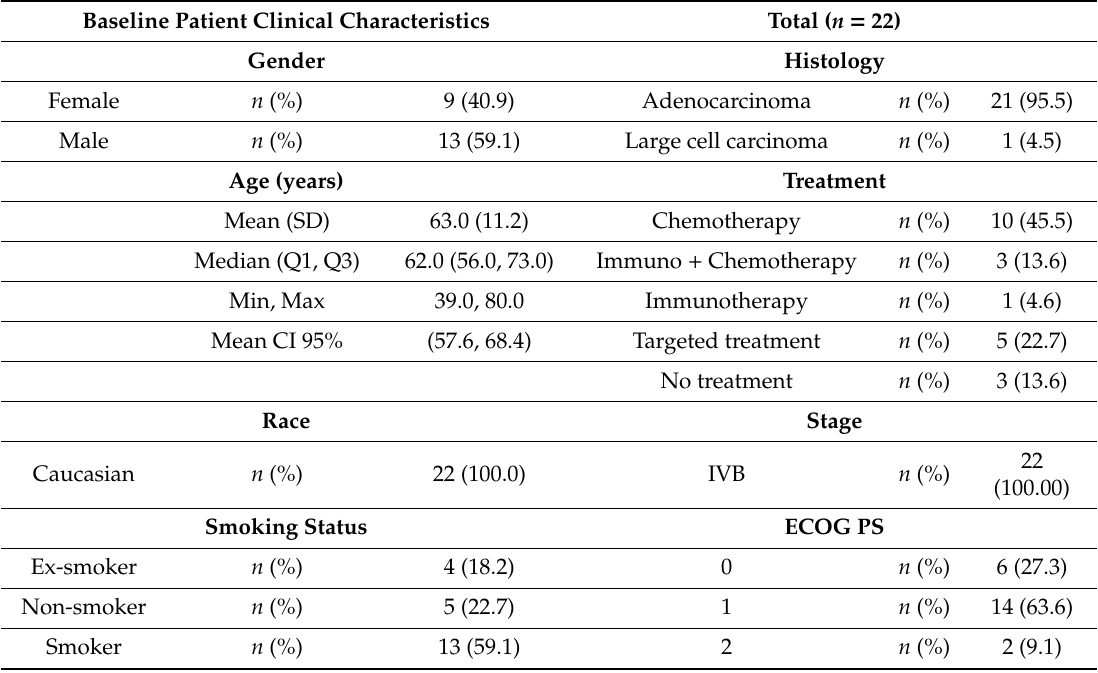
Table 1. Baseline clinical characteristics for all BRAF-alteration positive patients ( n =